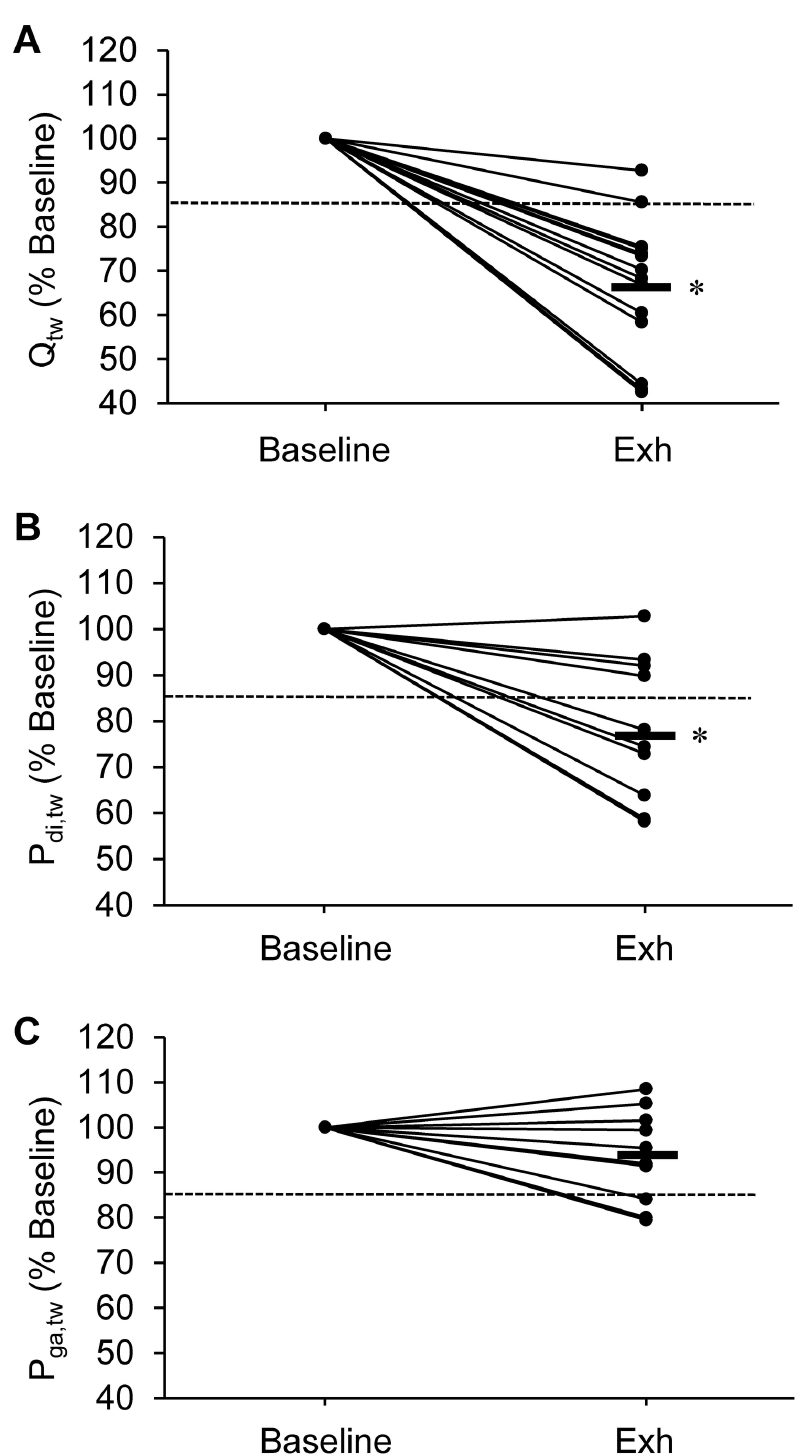
Figure 2. Individual changes in quadriceps strength evoked by femoral magnetic stimulation (Q ; Panel A), tw transdiaphragmatic pressure evoked by cervical magnetic stimulation (P ; Panel B) and gastric pressure evoked by di,tw thoracic magnetic stimulation (P ; Panel C) from before (Baseline) the constant-load cycling to immediately after ga,tw exhaustion (Exh). The thick line indicates the group average reduction. The dotted line indicates the 15% reduction threshold for significant amount of muscle fatigue. *, significant group difference from Baseline (P<0.05). doi: 10.1371/journal.pone.0083432.g002 PLOS ONE |